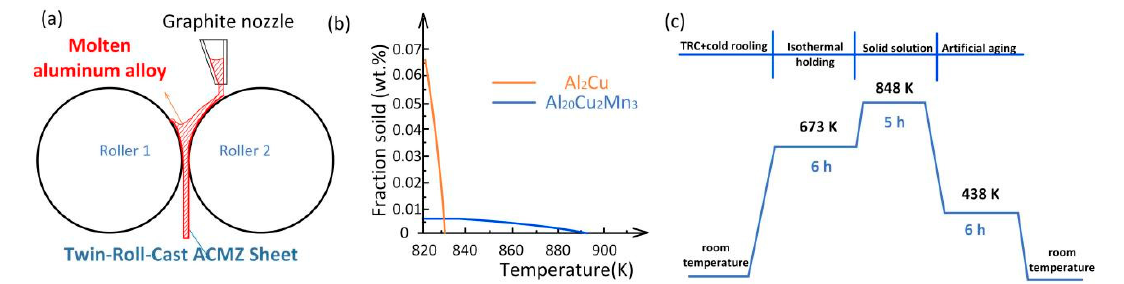
Figure 1. ( a ) Solidification process of asymmetric TRC machine; ( b ) Phase content after solidification Figure 1. ( a ): Solidification process of asymmetric TRC machine; ( b ): Phase content after solidifica- tion calculated by JMatPro according to the Scheil equation; ( c ): Heat treatment process for all alloys. calculated by JMatPro according to the Scheil equation; ( c ) Heat treatment process for all